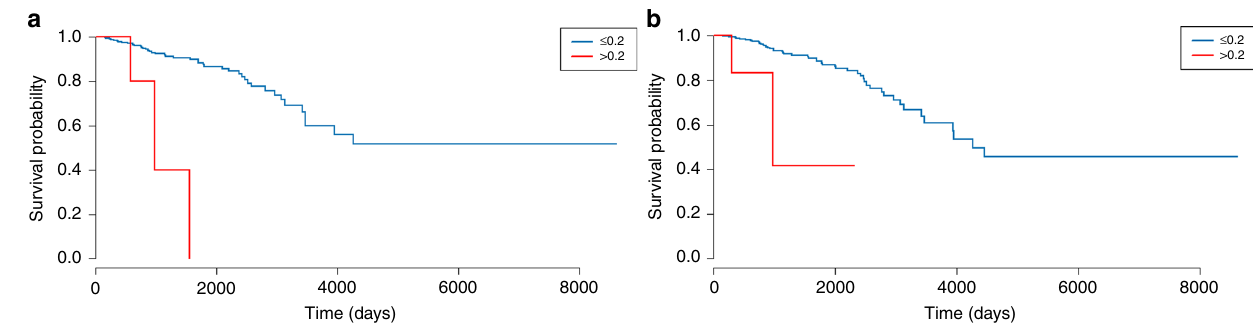
Fig. 4 Kaplan – Meier plot of the Cox proportional hazards model for survival as a function of differential imprinting. Differential imprinting is implemented continuously as the allelic ratio (AR) of the least expressed allele over the most expressed allele (with AR as categorical variable for the Kaplan – Meier plot: AR ≤ 0.2 (blue curve) and AR > 0.2 (red curve)), and age. a rs3732084 ( ZDBF2 ) b rs1975597 ( ZDBF2